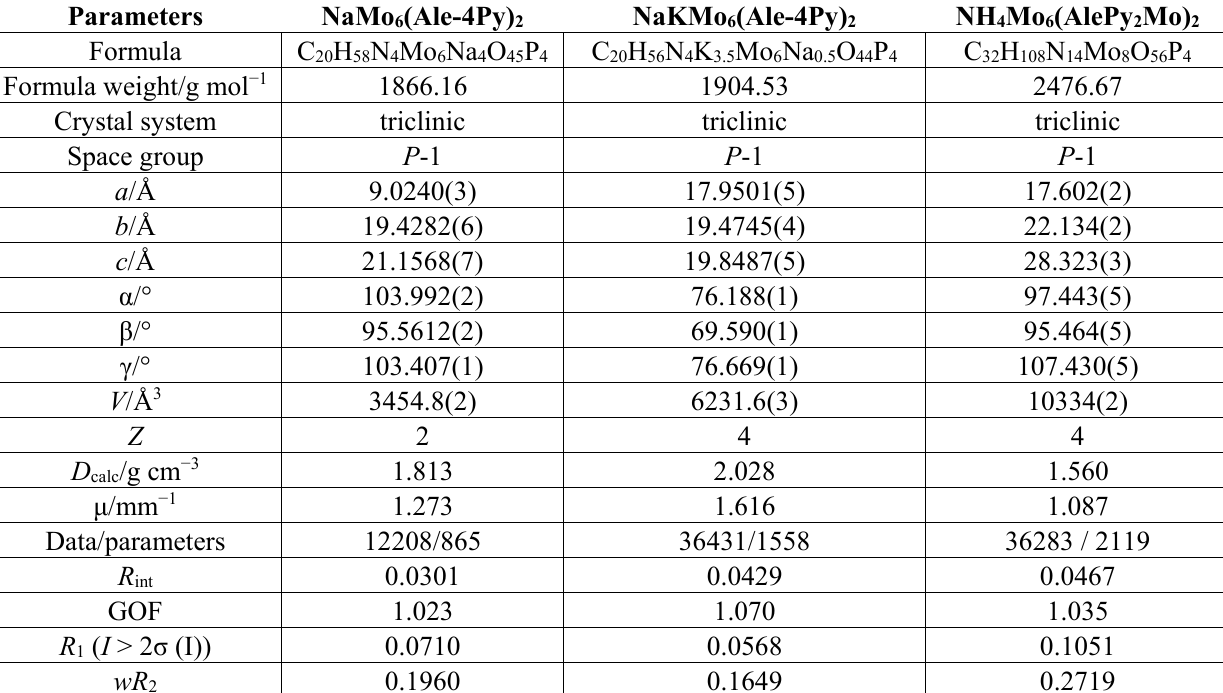
Table 2. Crystallographic